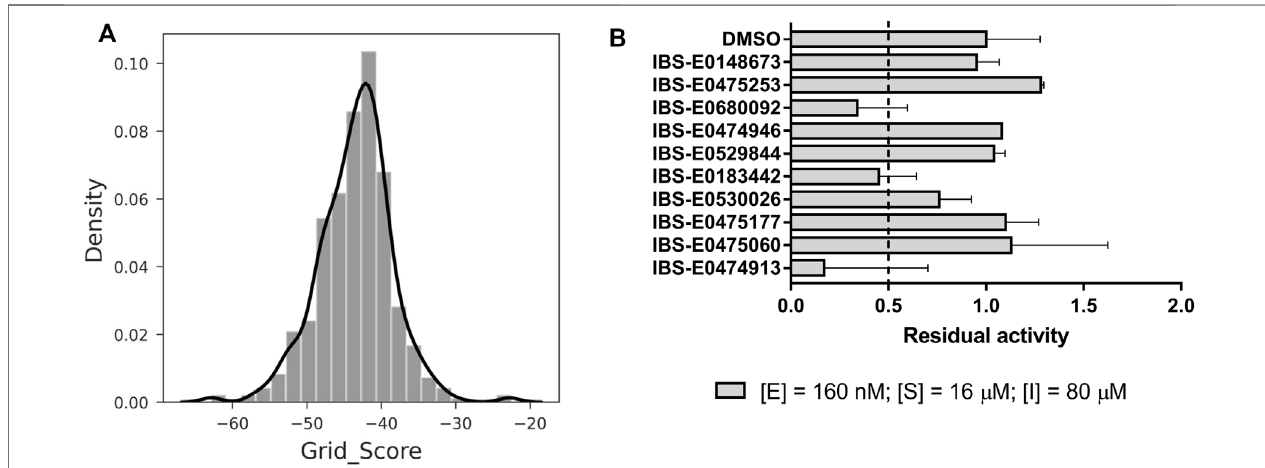
FIGURE 7 | Structure-based virtual screening and an assessment of inhibition ef fi cacy. (A) Docking score distribution for Generative Topographic Mapping hits. More negative values correspond to better scores. (B) Preliminary screening of the compounds for M pro inhibition.